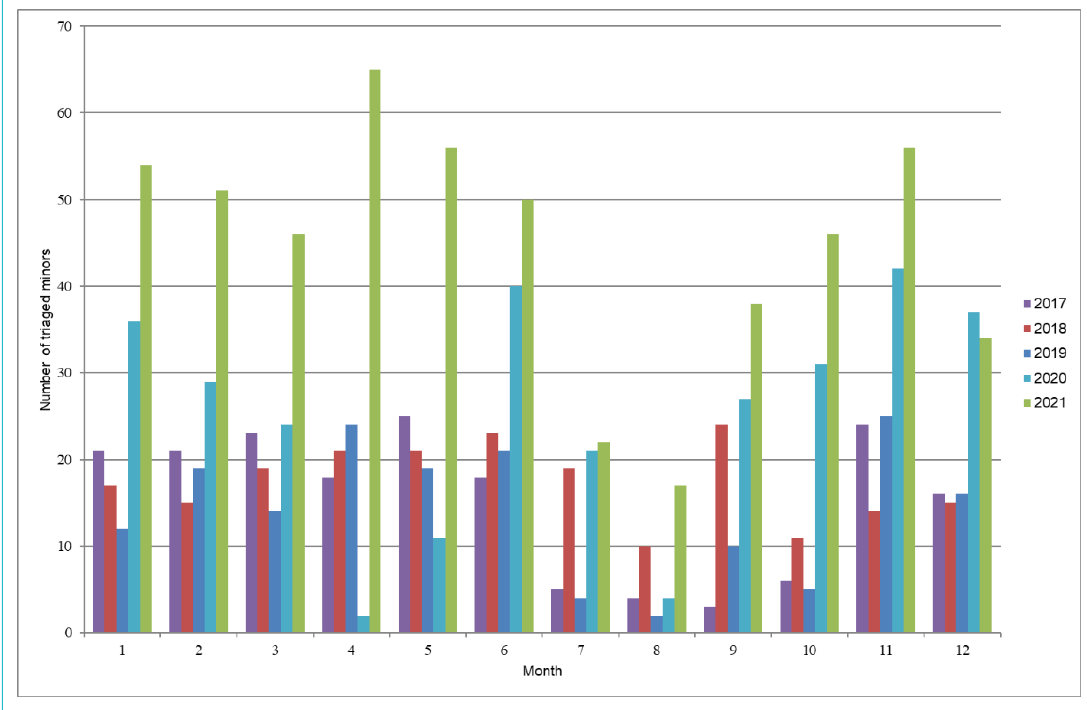
Figure 2: Emergency admissions of minors requiring inpatient treatment in adult psychiatry. In the canton of Zurich, minors requiring inpatient treatment are referred to adult psychiatry only if no less restrictive means are